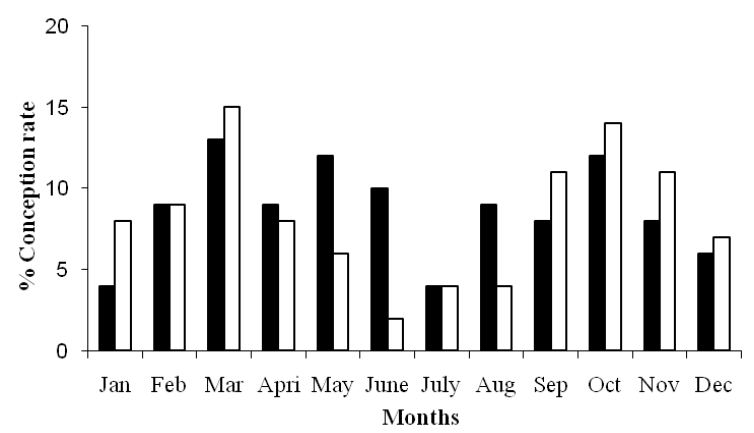
Figure 2. Observed pattern of conception rate during different months. Shown are the % of conception rates ( n = 308) of Arabian (□) and ( n = 336) of Thoroughbred (■) mares under subtropical conditions in Pakistan.